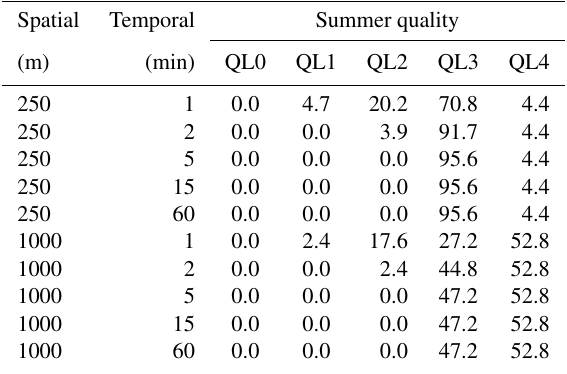
Table 2. Percent of grid cells (above land) within the city centre (red square in Fig. 2), for each quality level category for a